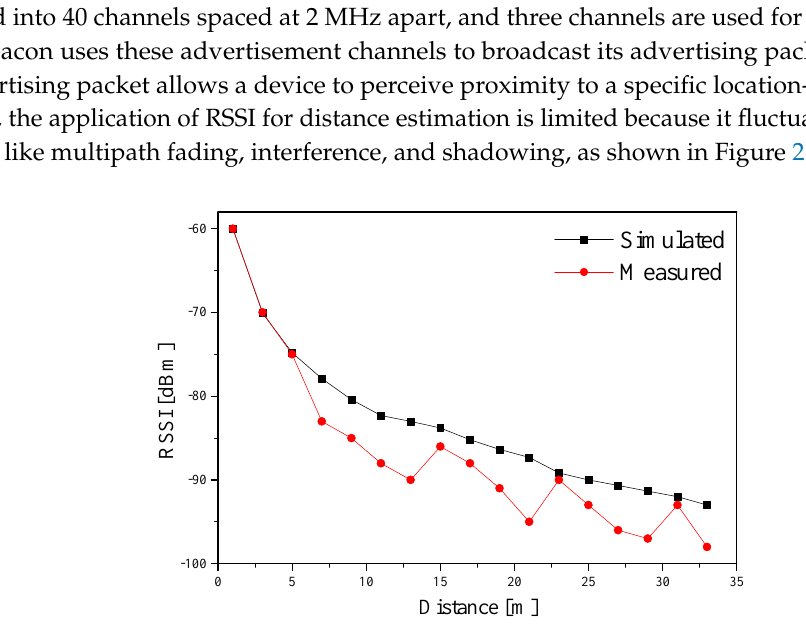
Figure 2. RSSI simulations and observations